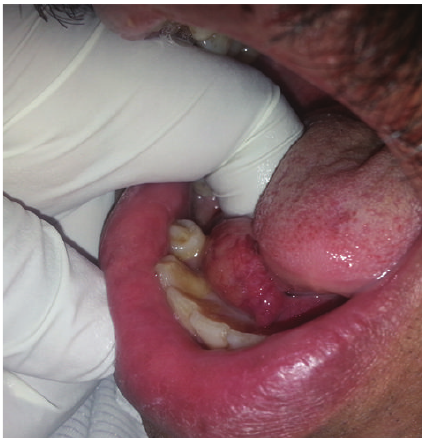
Figure 1: Intraoral palpation.